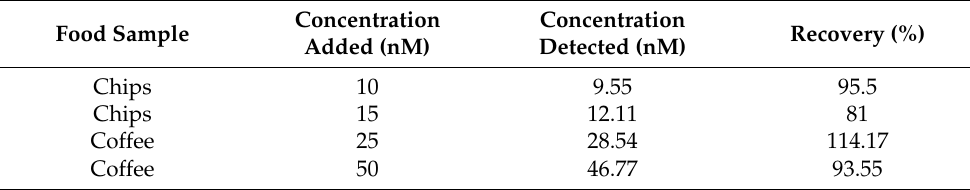
Table 2. Recoveries of ACR in Food